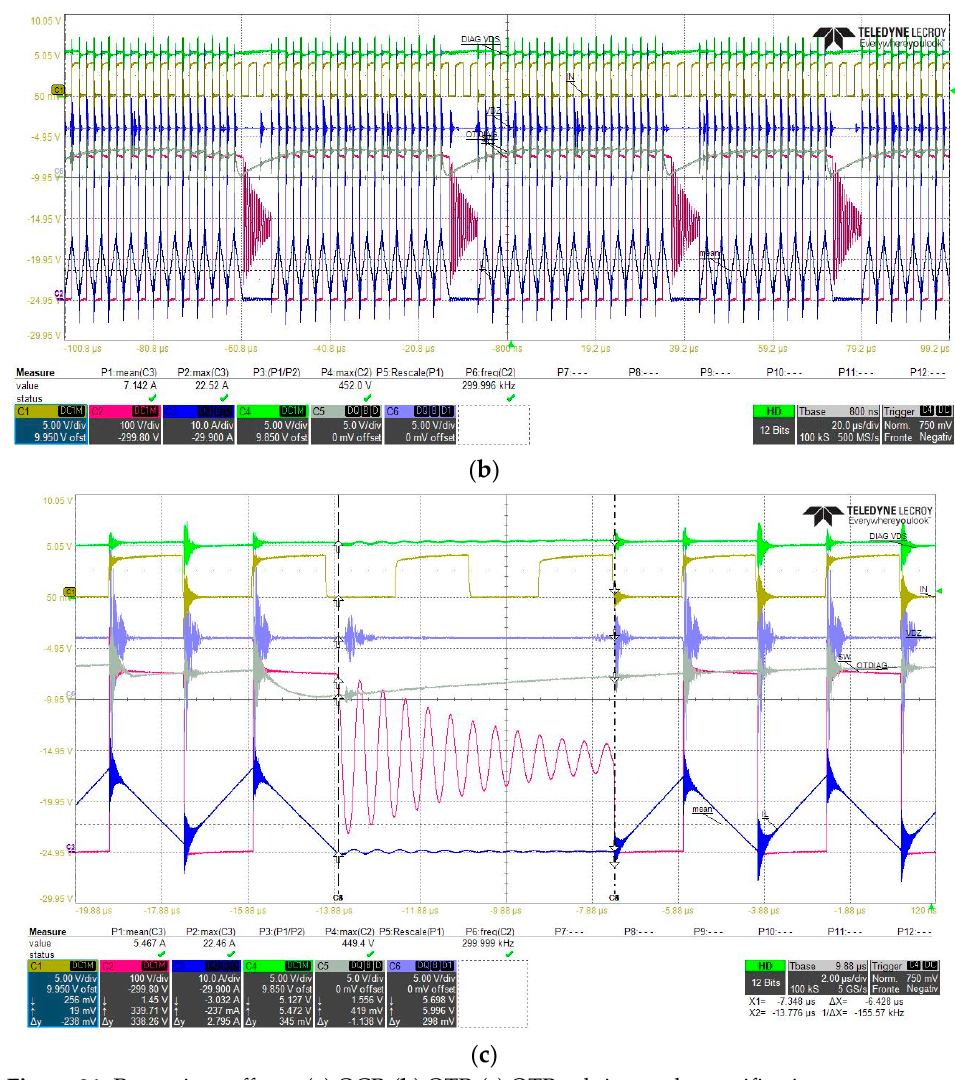
Figure 21. Protections effect—( a ) OCP, ( b ) OTP, ( c ) OTP sub-interval